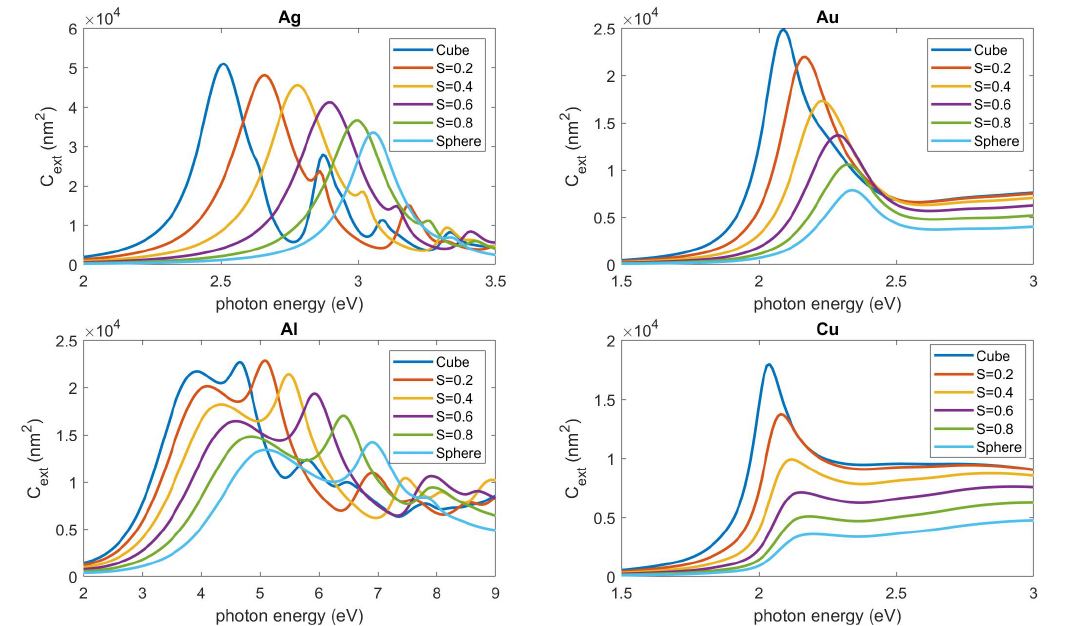
Figure 4. Extinction efficiency for Ag, Au, Al and Cu semi-cubes with varying shape parameter ( S ) and constant length of ( L = 25 nm) embedded in water ( (cid:101) h = 1.77).